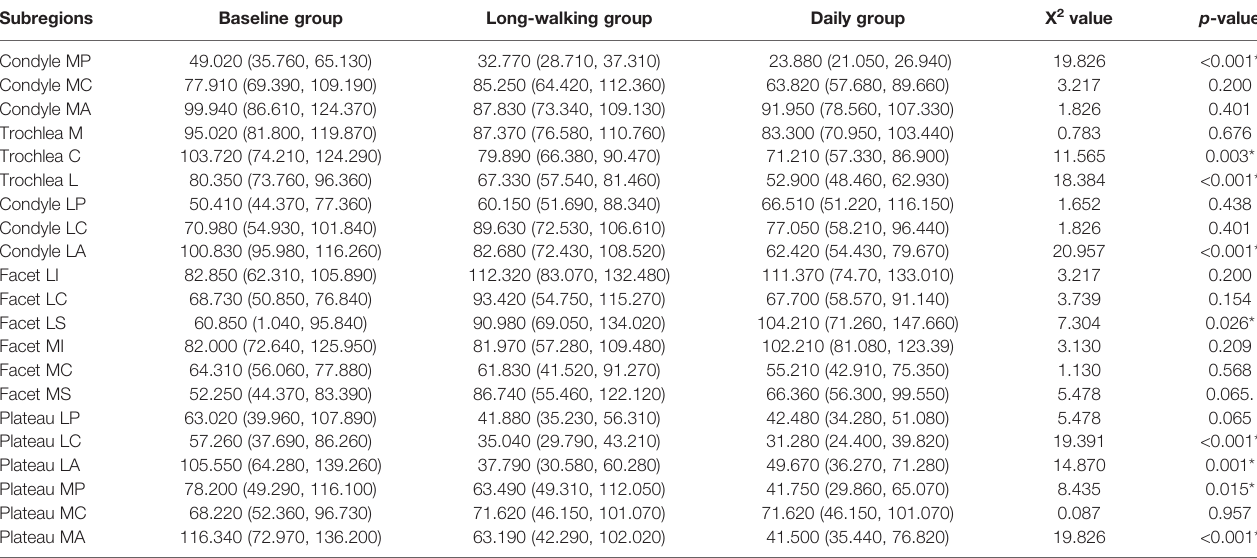
TABLE 6 | T2 values of the 21 sub-regions of knee cartilage in the three groups. Subregions Baseline group